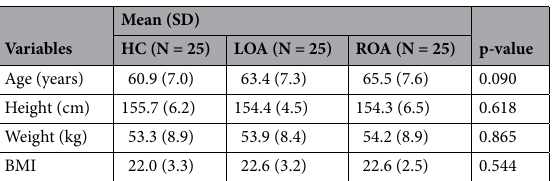
Table 1. Participant demographics. The means and standard deviations of age, height, weight and BMI for each group.